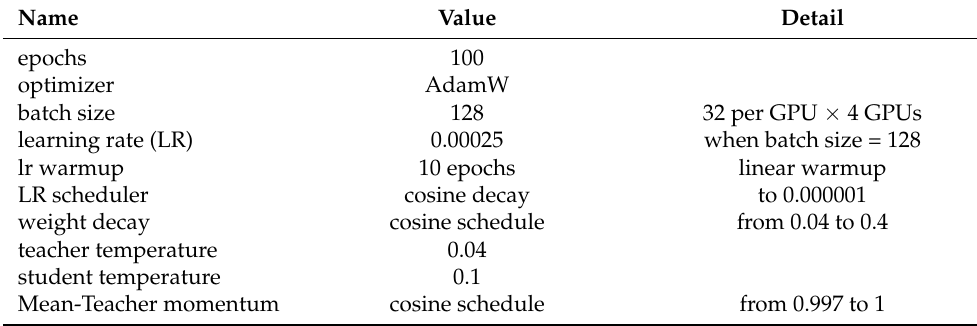
Table 3. Summary of the hyper-parameters in our self-supervised pre-training experiment.